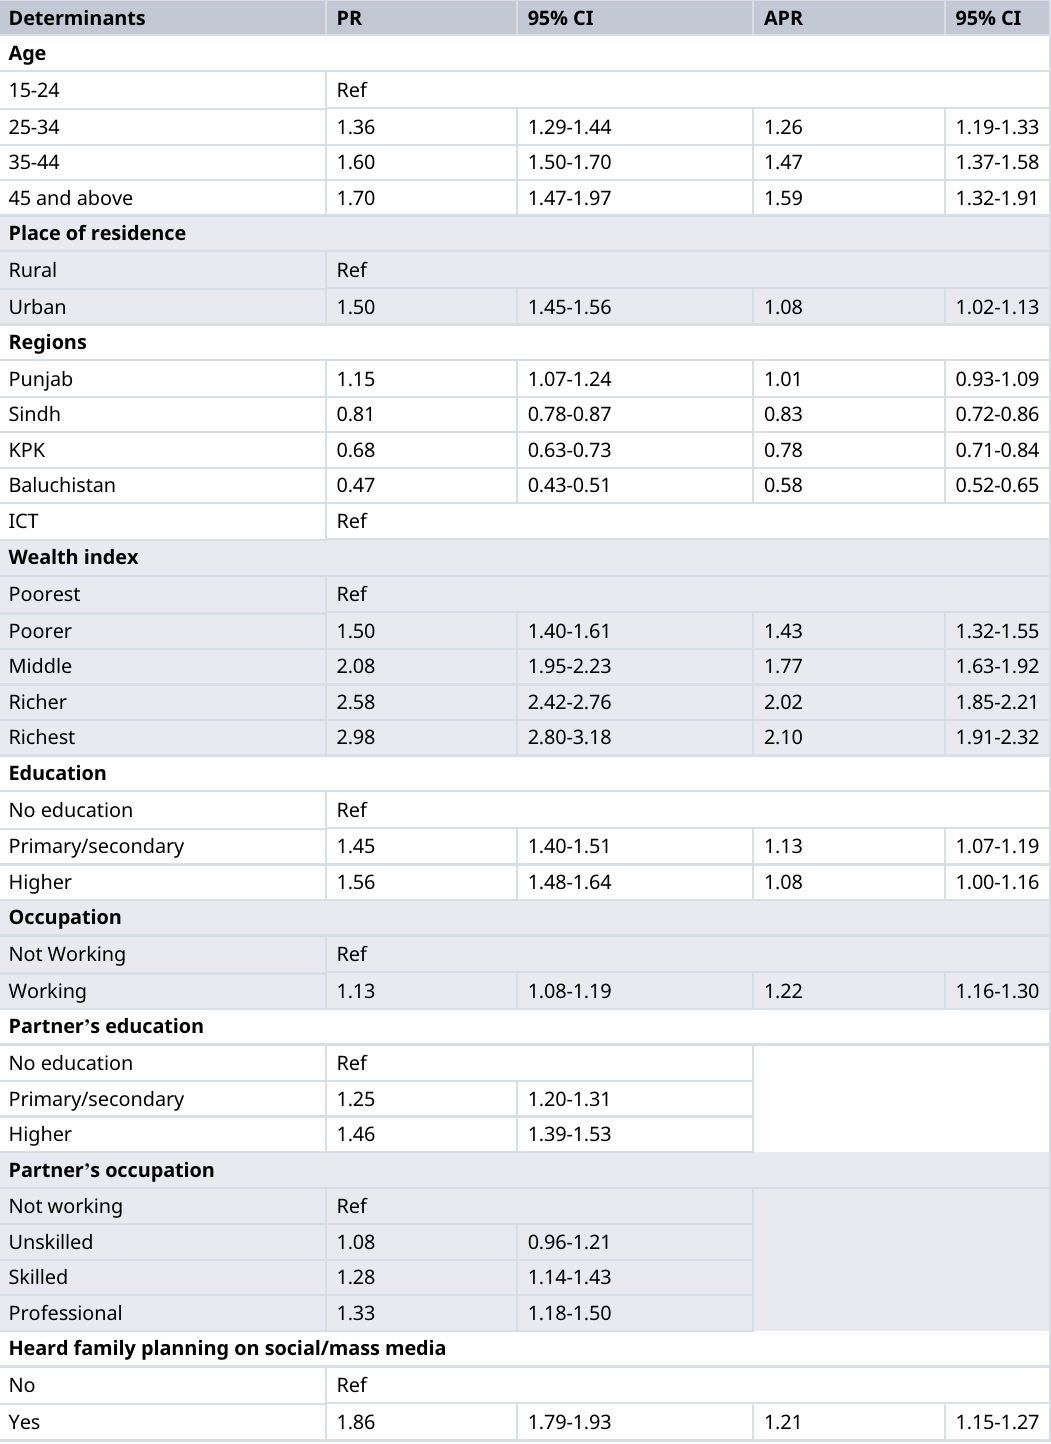
Table 2. Social determinants of women with respect to contraception usage.